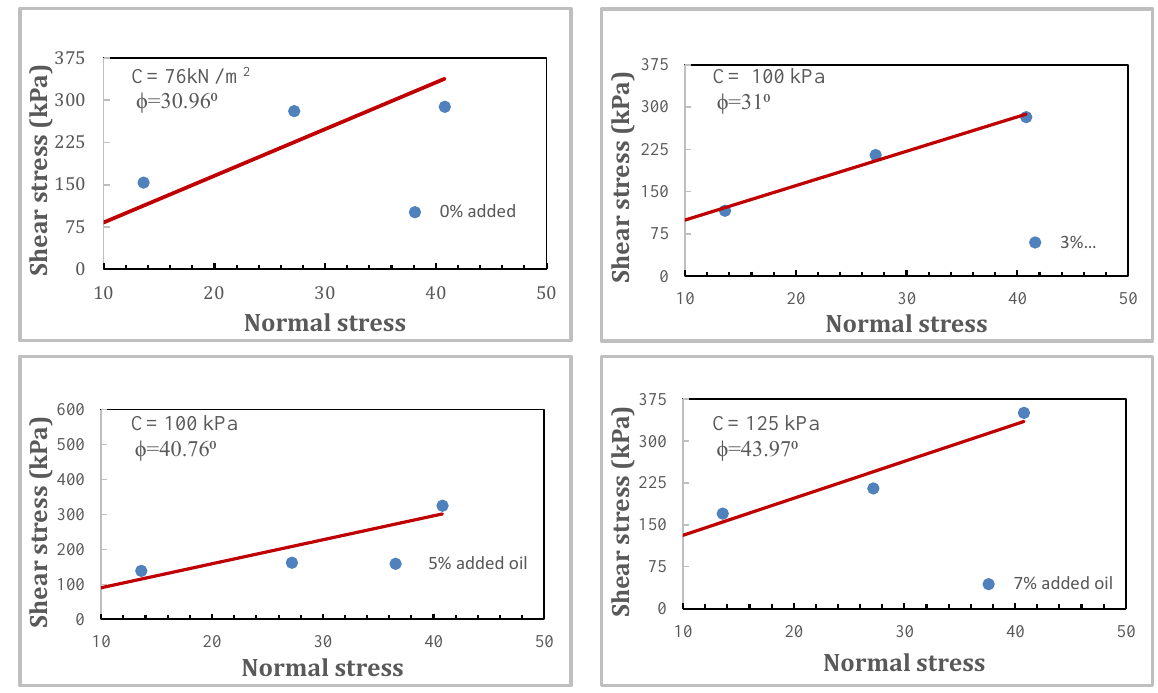
Figure 4: Shear stress versus normal stress values (failure envelope)